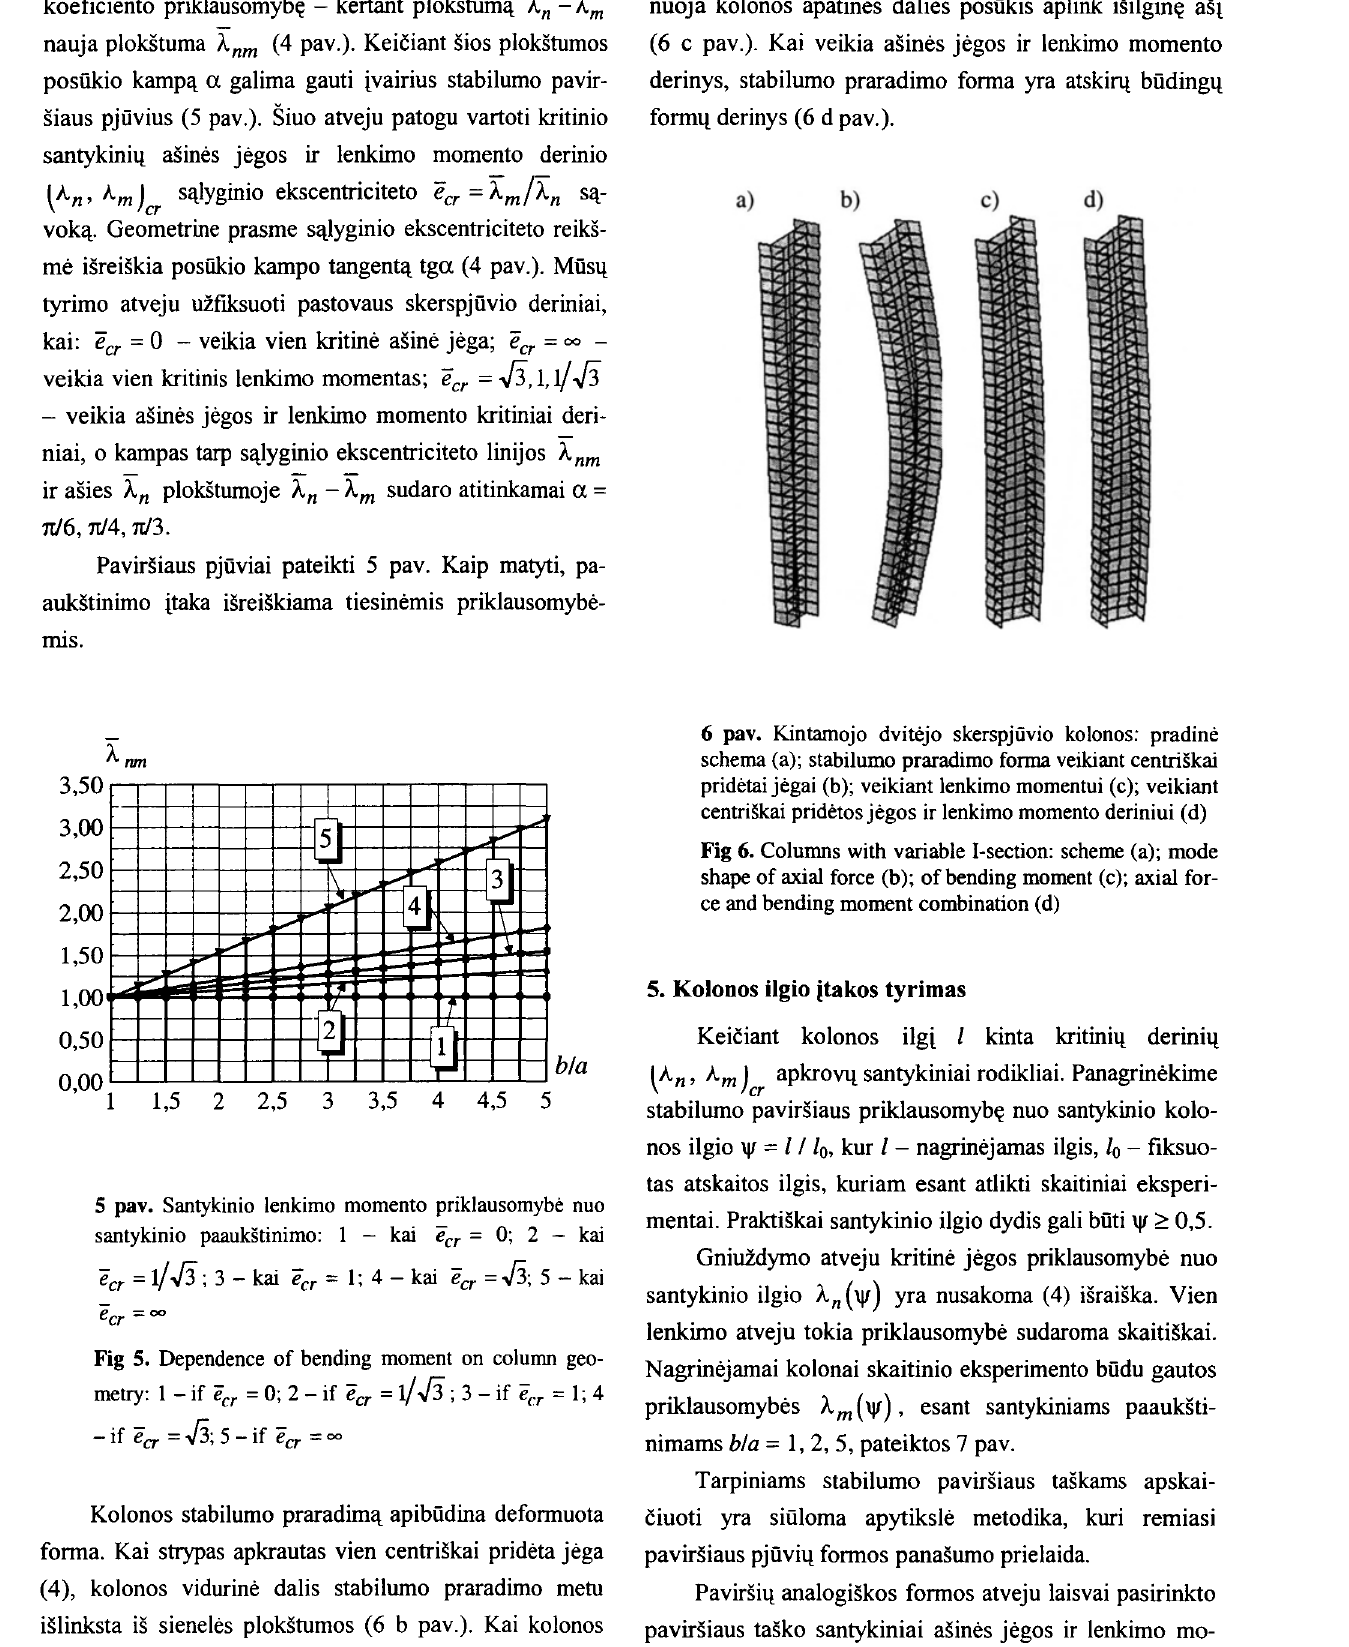
Fig 5. Dependence of bending moment on column geo